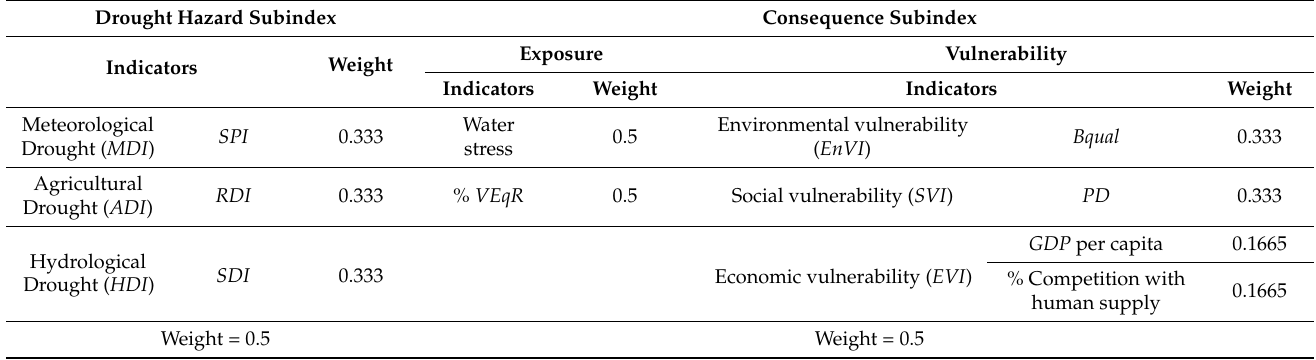
Table 6. Weights used for W-ScaRI calculation.